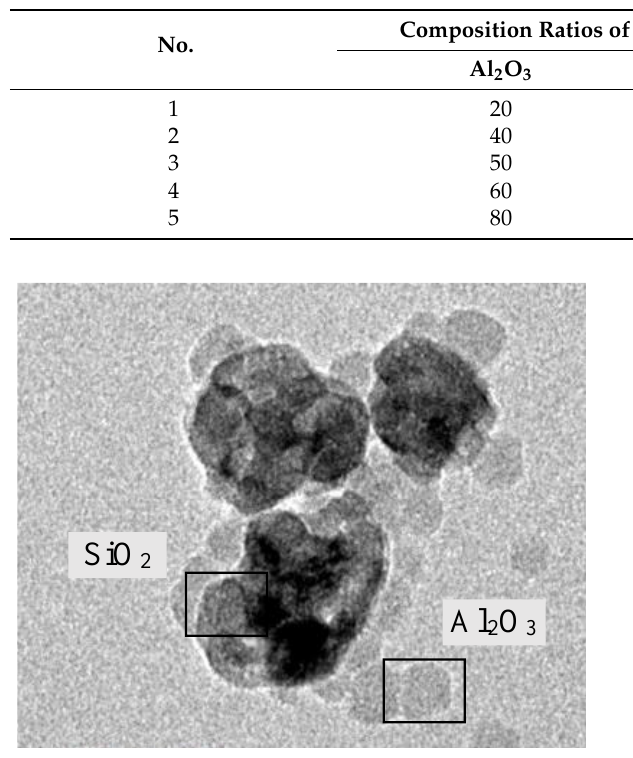
Table 3. Designated nanoparticle composition ratios.